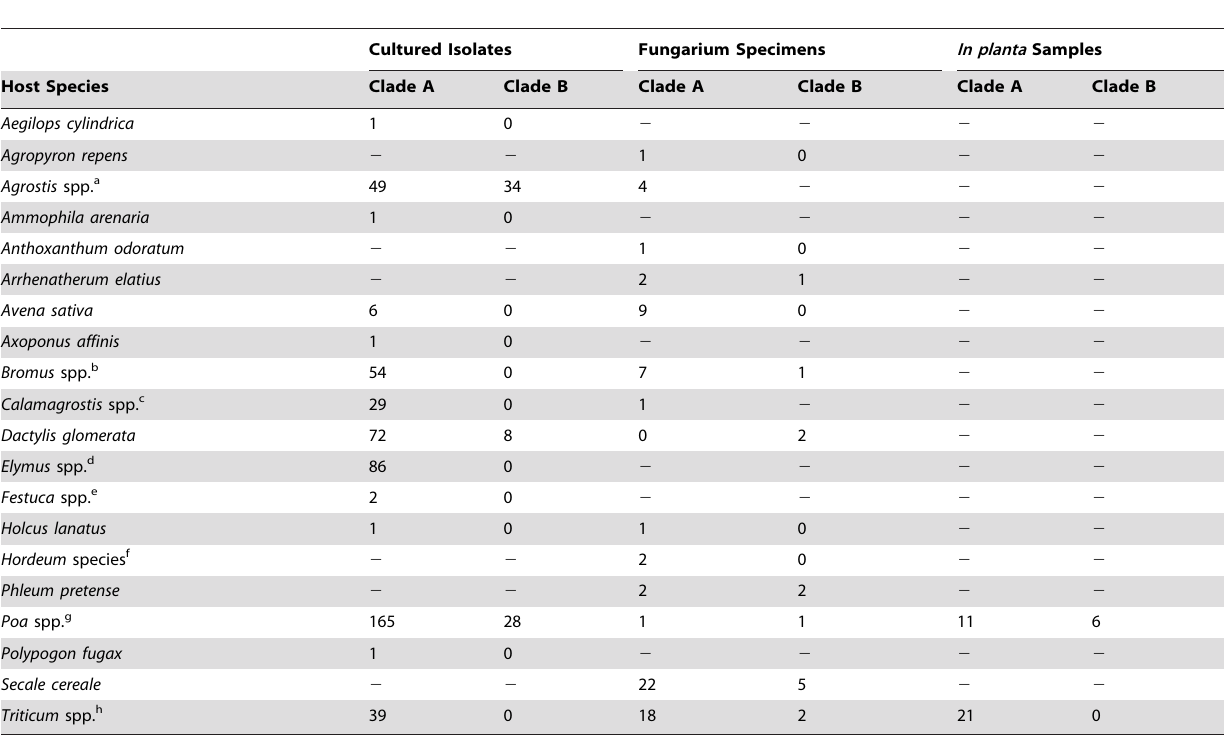
Table 3. Summary of the diagnosis of Colletotrichum cereale subgroups by host species using the Apn2 real-time detection assays, A-Apn2 and